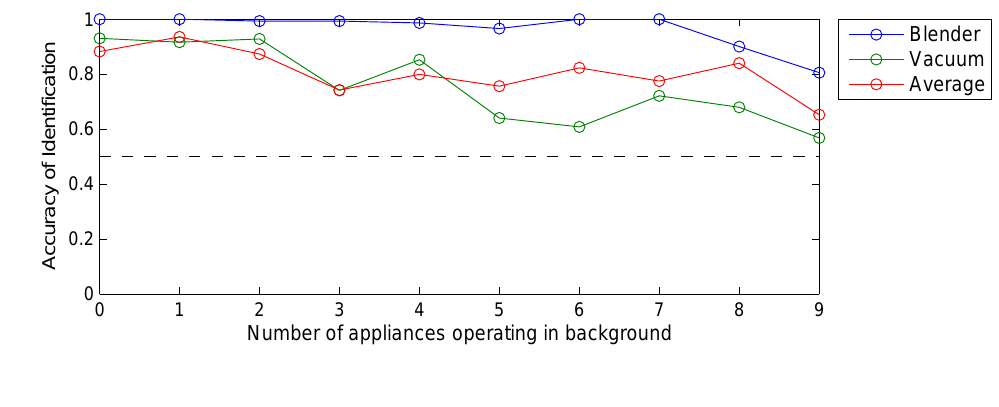
Figure 9. Identification accuracy for specific appliances as more appliances are added to operate in the